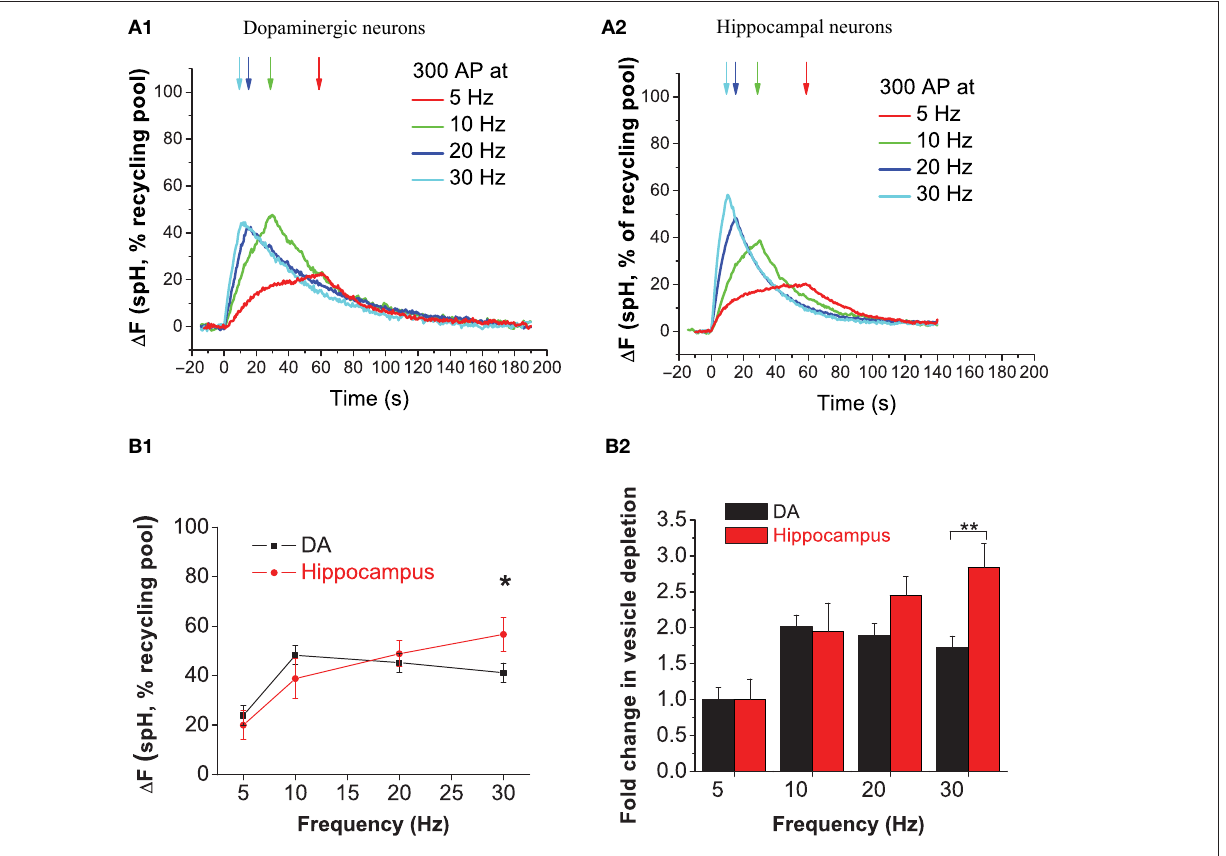
FIGURE 3 | Increasing stimulus frequency from 5 to 30 Hz causes limited depletion of DA synaptic vesicles. (A1, A2) Average increase in presynaptic spH fl uorescence due to 300 stimuli at 5- (red), 10- (green), 20- (blue), or 30 Hz (cyan) in dopaminergic (A1) and hippocampal (A2) neurons. Arrows indicate the end of the stimulus, which began at time 0 s in all trials. Responses are normalized to the size of the total recycling pool of vesicles, which is measured by the maximum, saturating Δ F in the presence of bafi lomycin (See Section ‘Materials and Methods’). (B1) With a 30 Hz 300 AP stimulus, DA neurons (black